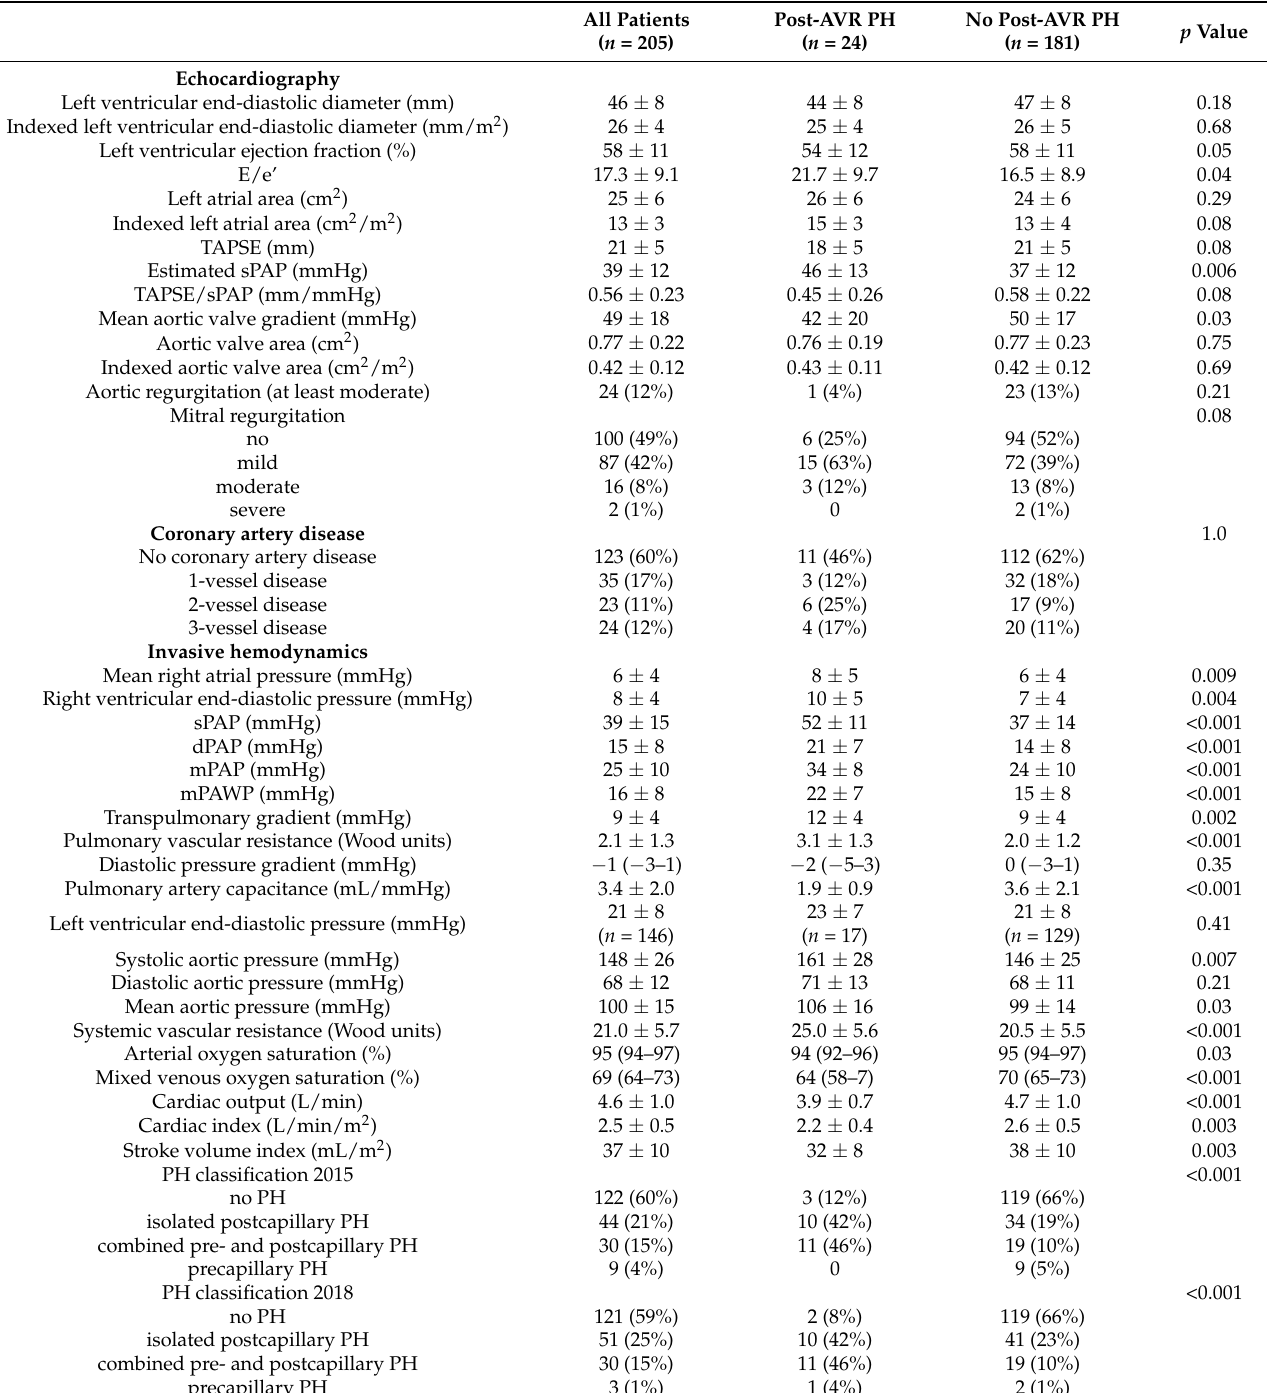
Table 2. Pre-aortic valve replacement data from echocardiography and cardiac catheterization of the entire study population and patients with versus without pulmonary hypertension after aortic valve replacement (post-AVR